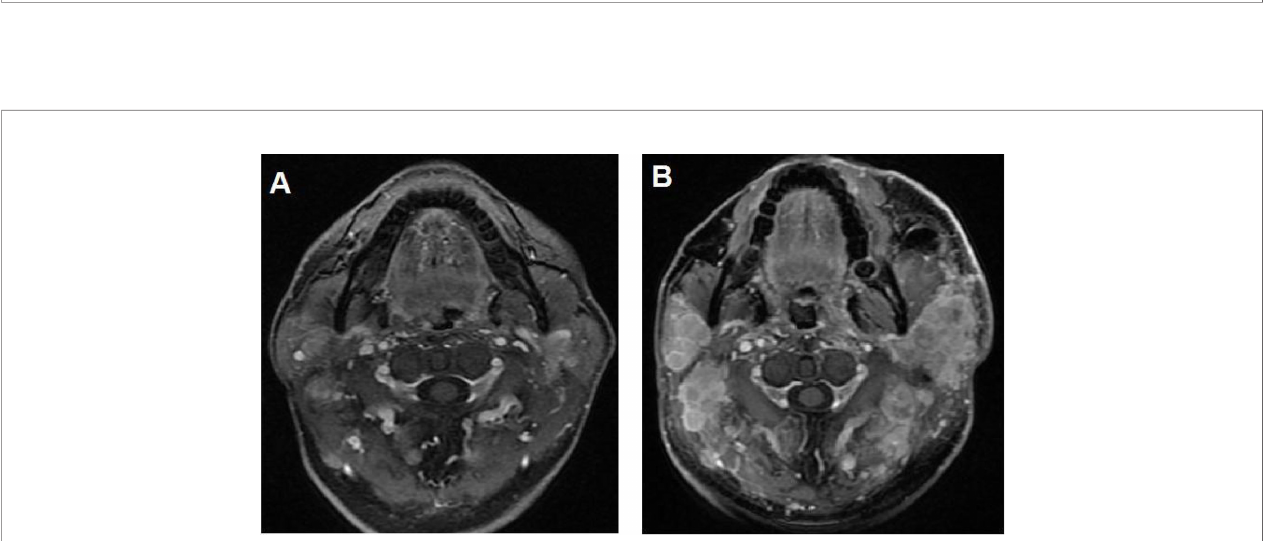
FIGURE 2 | Illustration of a typical recurrent nasopharyngeal carcinoma (NPC) case showing hyperprogressive disease (HPD) after immune checkpoint inhibitor (ICI) treatment alone. (A) Baseline magnetic resonance imaging (MRI) demonstrating multiple metastatic disease lesions in the bilateral neck. (B) MRI showing HPD in the bilateral neck after 2 cycles of ICI